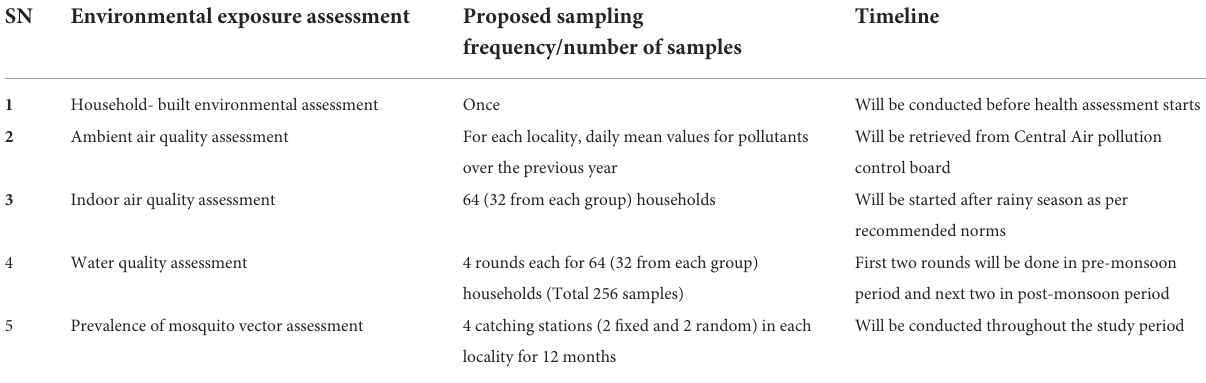
TABLE 1 Proposed sampling frequency of environmental exposure